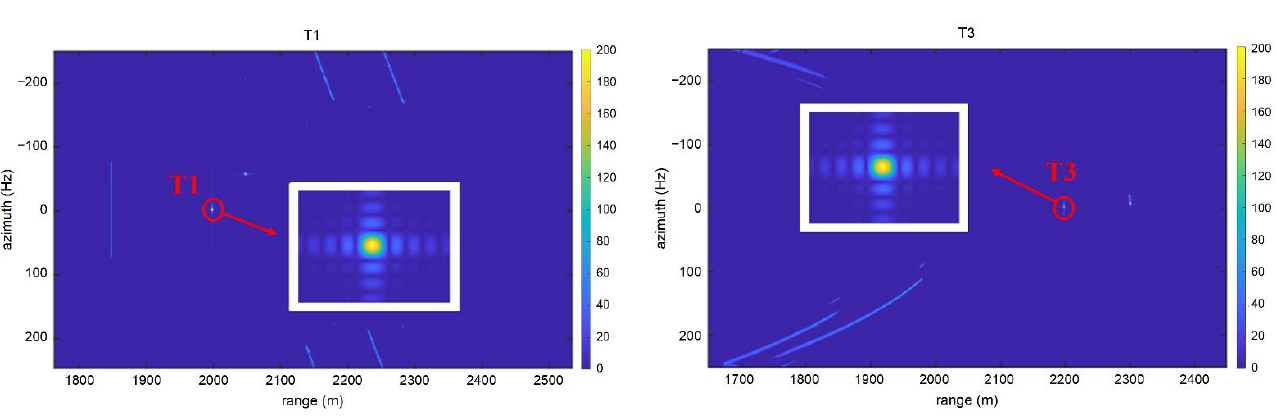
Figure 7. Refocused result of the moving targets T1 and T3.